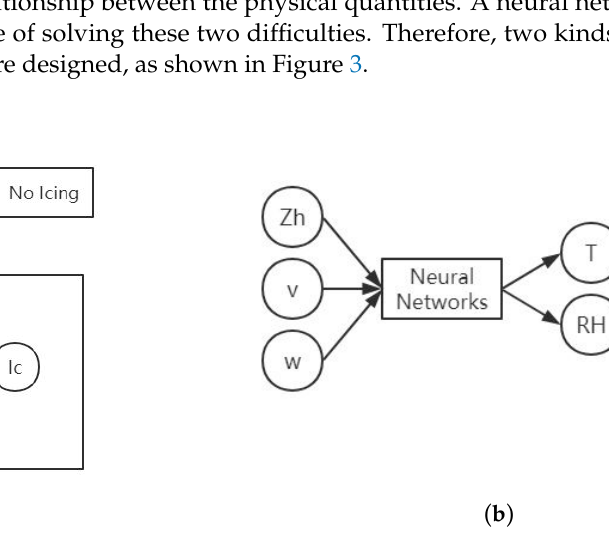
Figure 3. Calculation of icing index based on neural network. Structure 1 takes the Zh, v, and w as input to judge whether there is icing. For points with icing, another network is used to calculate the icing index, and for points without icing, it is directly output no-icing. Structure 2 takes the Zh, v, and w as input, takes temperature and relative humidity as output, and calculates the icing index according to Equation (1). ( a ) Neural Network Structure 1; ( b ) Neural Network Structure 2.